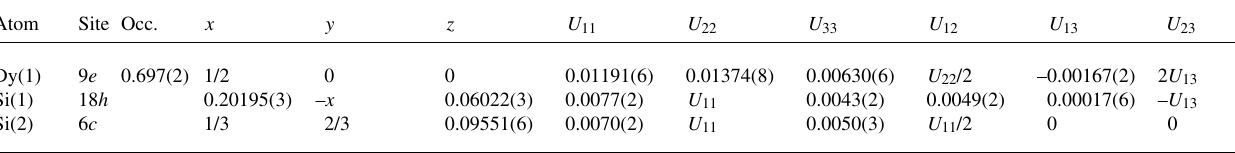
Table 3. Atomic coordinates and displacement parameters (in Å 2 ) .